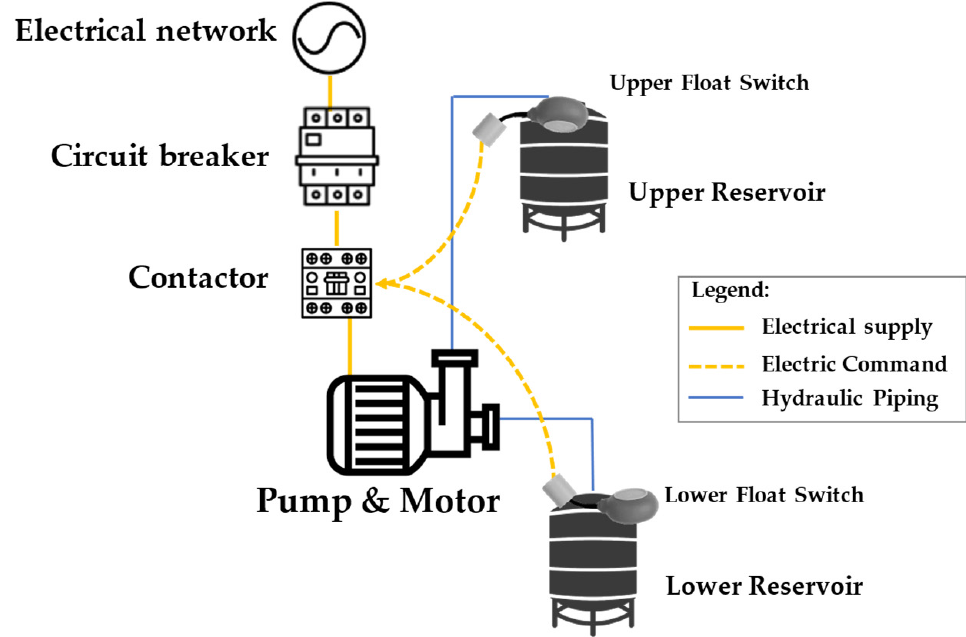
Figure 2. A traditional electrical schematic of the pumping system.